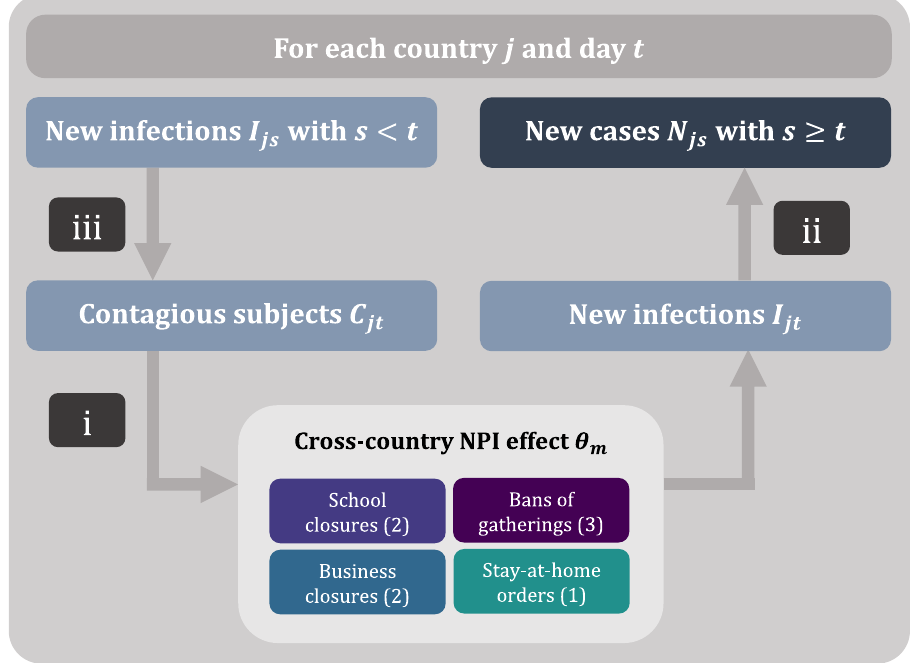
Figure 2. Visual summary of the model structure. The three main components are: (i) The number of new infections is modelled as a function of the number of contagious subjects, the country-specific daily transmission rate, and the reductions from 8 active NPIs (school and university closures, bans of gatherings larger than 10, 100, and 1000 people, closure of some or most high-risk face-to-face businesses, and stay-at- home orders). (ii) The observed number of new cases is a weighted sum of the number of new infections in the previous days. (iii) The number of contagious subjects is a weighted sum of the number of new infections in the previous